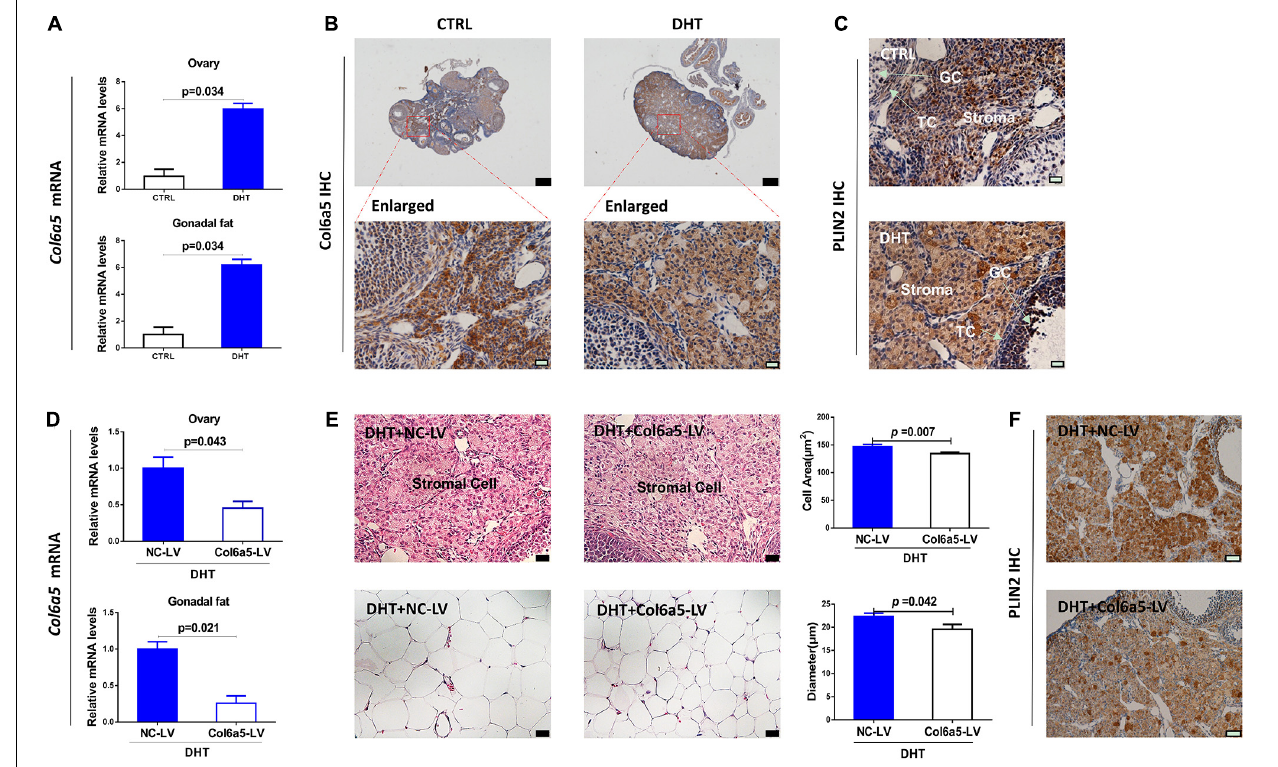
FIGURE 3 | Inhibition of Col6a5 expression alleviated the hypertrophy of ovaries and gonadal fat pads in DHT-treated mice. (A) Relative expression of Col6a5 mRNA in the ovaries and gonadal fat pads showing a significant increase in Col6a5 expression after DHT treatment; n = 6. The data are expressed as the mean ± SEM and were compared by Mann-Whitney U -test. (B) Immunohistochemistry of Col6a5 in the ovaries showing a significant positive signal in ovarian stromal cells; n = 3, top, scale bars = 200 µ m; bottom, scale bars = 20 µ m. (C) Immunohistochemistry of PLIN2 (a marker of lipid droplets) in the ovaries showing a significant positive signal in hypertrophic ovarian stromal cells (GC, granulosa cells, TC, thecal cells); n = 3, scale bars = 20 µ m. (D) Relative expression of Col6a5 mRNA in the ovaries and gonadal fat pads was decreased in DHT- treated mice after Col6a5 -LV injection; n = 6. The data are expressed as the mean ± SEM and were compared by Mann-Whitney U -test. (E) Histological images and mean size of ovarian stromal cells and gonadal adipocytes showing enhanced hypertrophy in DHT-treated mice after Col6a5 -LV injection, the cell area is based on the same measurement as in Figure 1F ; n = 6, scale bars = 20 µ m. The data are expressed as the mean ± SEM and were compared by Mann-Whitney U -test. (F) Immunohistochemistry of PLIN2 (a marker of lipid droplets) in the ovaries showing decreased accumulation of lipid droplets in DHT-treated mice after Col6a5 -LV injection; n = 3, scale bars = 20 µ